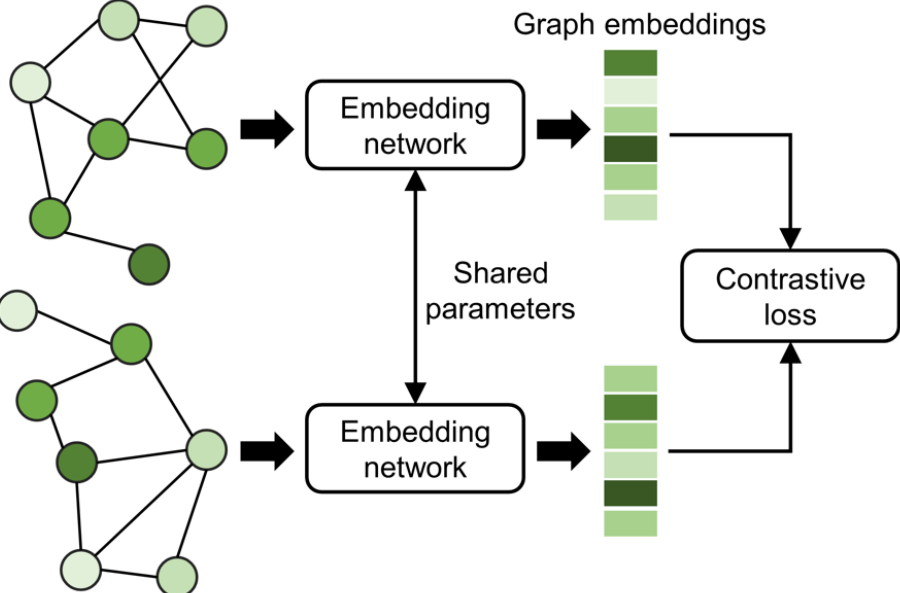
Figure 6. Architecture of Siamese-GraphSite. This model requires a pair of graph-structured data as the input for two embedding networks sharing their parameters and utilizes the contrastive loss function.